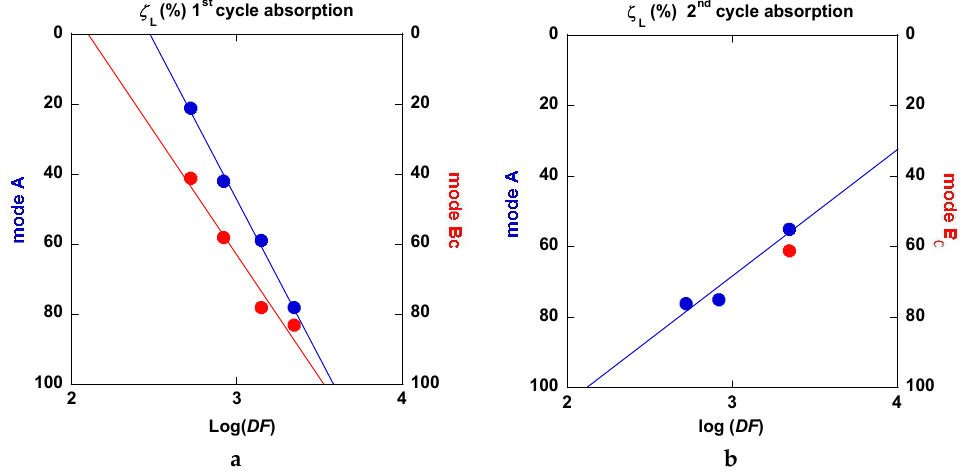
Figure 33. Limit value ξ L (%) of the change in kinetic process vs. log( DF ). Blue dots are for ECAP mode A, red dots are for ECAP mode B C . ( a ): for the 1st hydrogenation ( b ): for the 2nd hydrogenation.